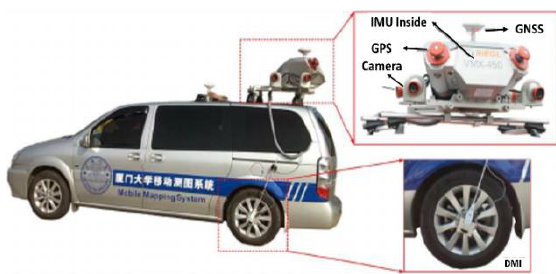
Figure 1. The MTLS technology with its sensors(Yu et al.,